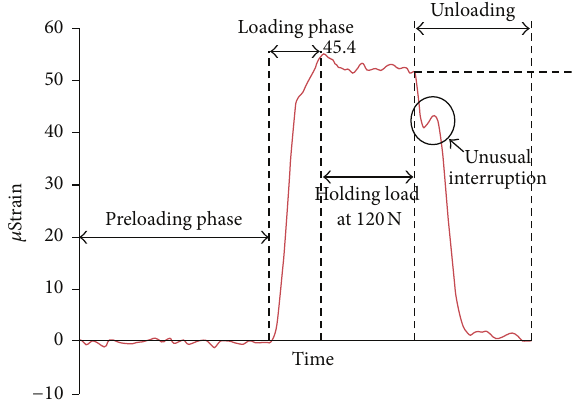
Figure 8: Microstrain-time plot of gauge 1 illustrating preloading, loading, and unloading microstrain behaviour during a bilateral uniform loading cycle.